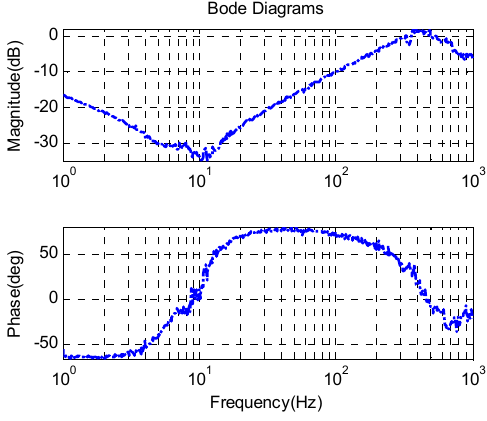
Figure 13. Disturbance suppression characteristics of the acceleration closed-loop.